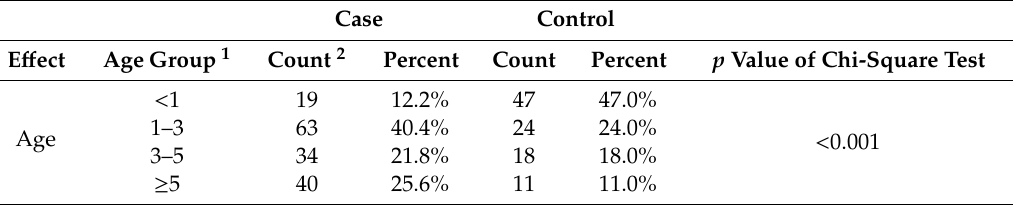
Table 3. Statistical analysis of age effect on acute cytauxzoonosis and control case incidence.